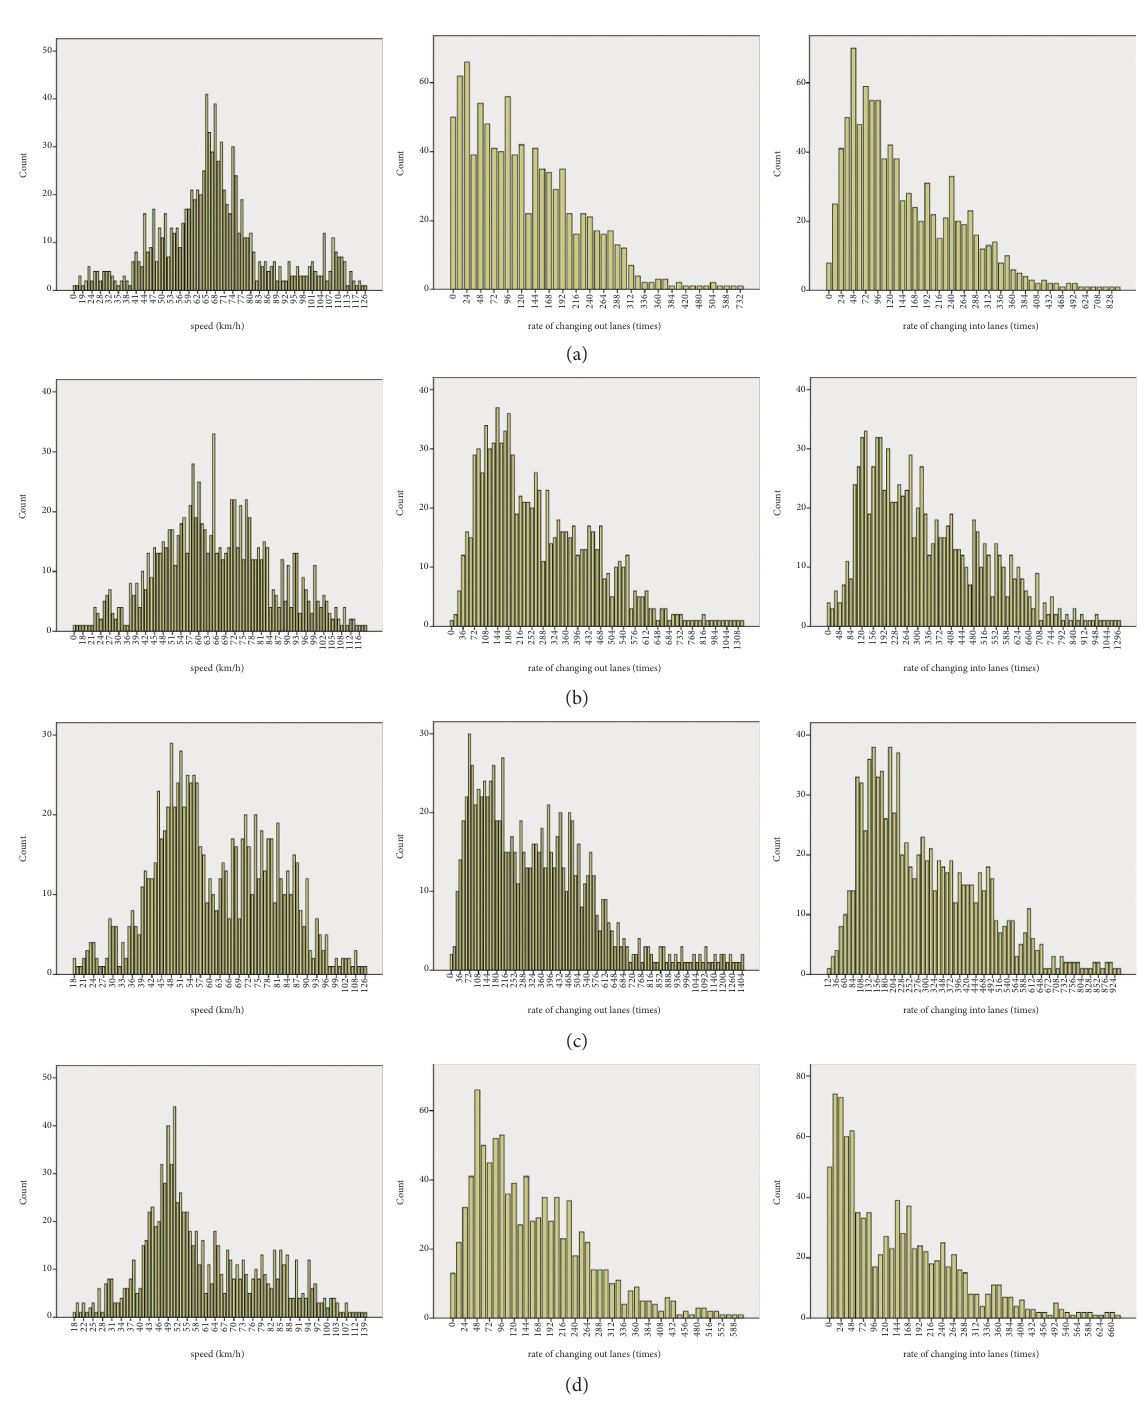
Figure 4: Data distribution histogram. (a) The histogram of Lane 1 speed, the rate of changing into lanes, and the rate of changing out of lanes. (b) The histogram of Lane 2 speed, the rate of changing into lanes, and the rate of changing out of lanes. (c) The histogram of Lane 3 speed, the rate of changing into lanes, and the rate of changing out of lanes. (d) The histogram of Lane 4 speed, the rate of changing into lanes, and the rate of changing out of